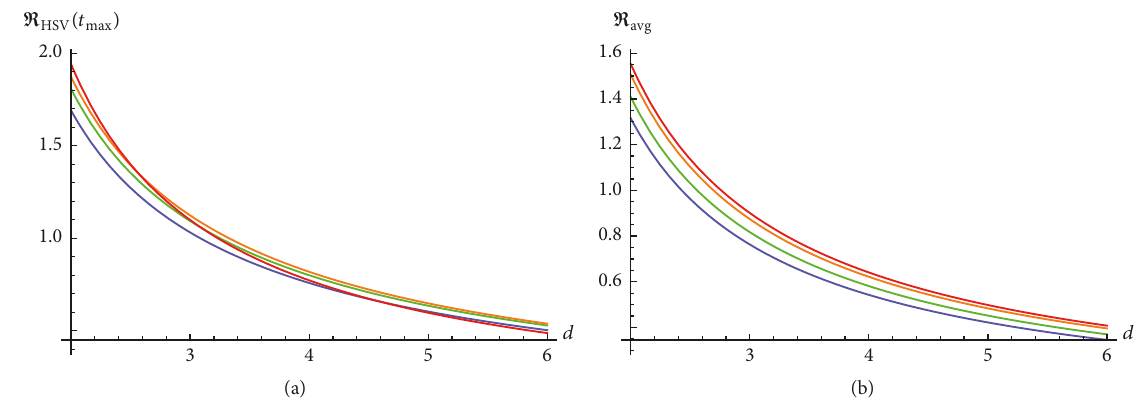
Figure 4: (a) Maximum and (b) average entanglement velocities as a function of 𝑑 . The colors blue, green, orange, and red correspond to 𝑧 = {1.3,1.5, 1.9,2.7} , respectively, and we have set 𝜃 = 0.1 , 𝑡